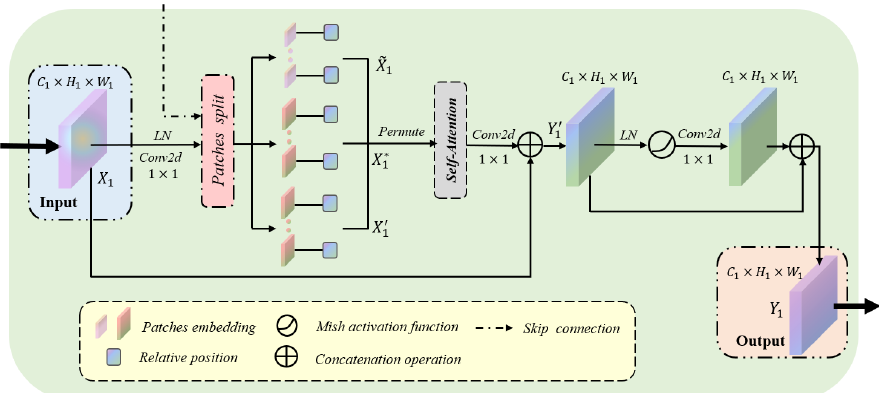
Figure 2. The specific structure of the context-attention module, where LN is the layer normalization operator, and C 1 × H 1 × W 1 represents the map shape (channel, height and width).